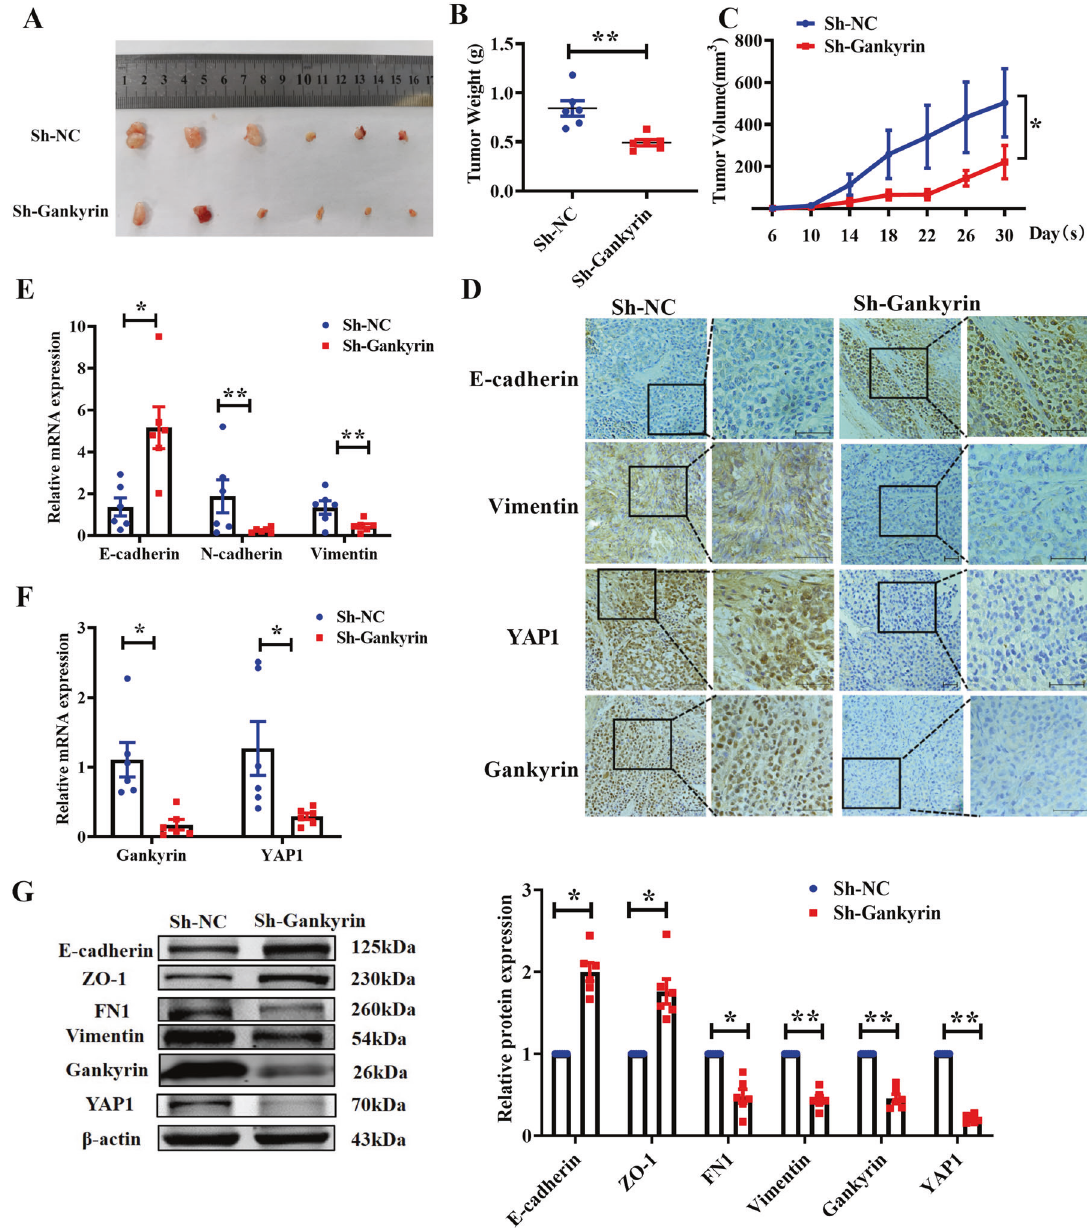
Fig. 8 Gankyrin knockdown inhibits EMT and tumor progression in vivo. A Macroscopic observation of the size of tumor nodules in nude mice bearing xenograft tumors with A549-sh-Gankyrin or sh-NC. B Statistical analysis of tumor weight in different groups ( n = 6, ** P < 0.01). C Statistical analysis of tumor growth curves in different group ( n = 6, * P < 0.05). D Immunohistochemistry assay was applied to determine the expression of E-cadherin, Vimentin, YAP1, and Gankyrin in a cell-derived xenograft tumor model (Scale bars: 100 μ m). E , F Expression of Gankyrin, and YAP1, and EMT-relevant markers, including E-cadherin, N-cadherin, and Vimentin in different groups, as determined by using qRT-PCR ( n = 6, * P < 0.05, ** P < 0.01). G Western blotting assay results show the protein levels of the EMT-relevant markers E-cadherin, ZO-1, FN1, N-cadherin, and Vimentin ( n = 6, * P < 0.05, ** P <